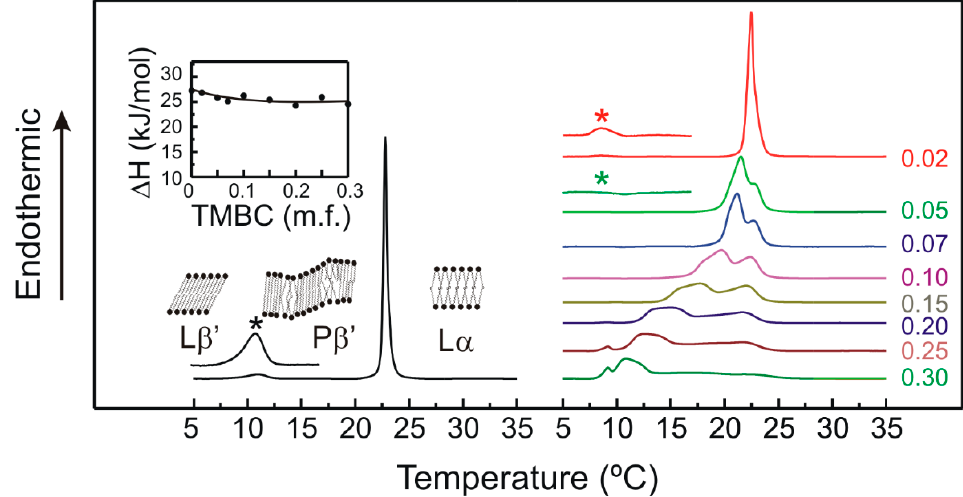
Figure 2. DSC heating thermograms for pure DMPG (left) and DMPG containing TMBC at different concentrations (right). Inset shows the enthalpy change for the main gel to liquid-crystalline phase transition. TMBC mole fraction is expressed on the right side of the thermograms. Asterisks indicate the enlarged region (×7) of the pretransition.